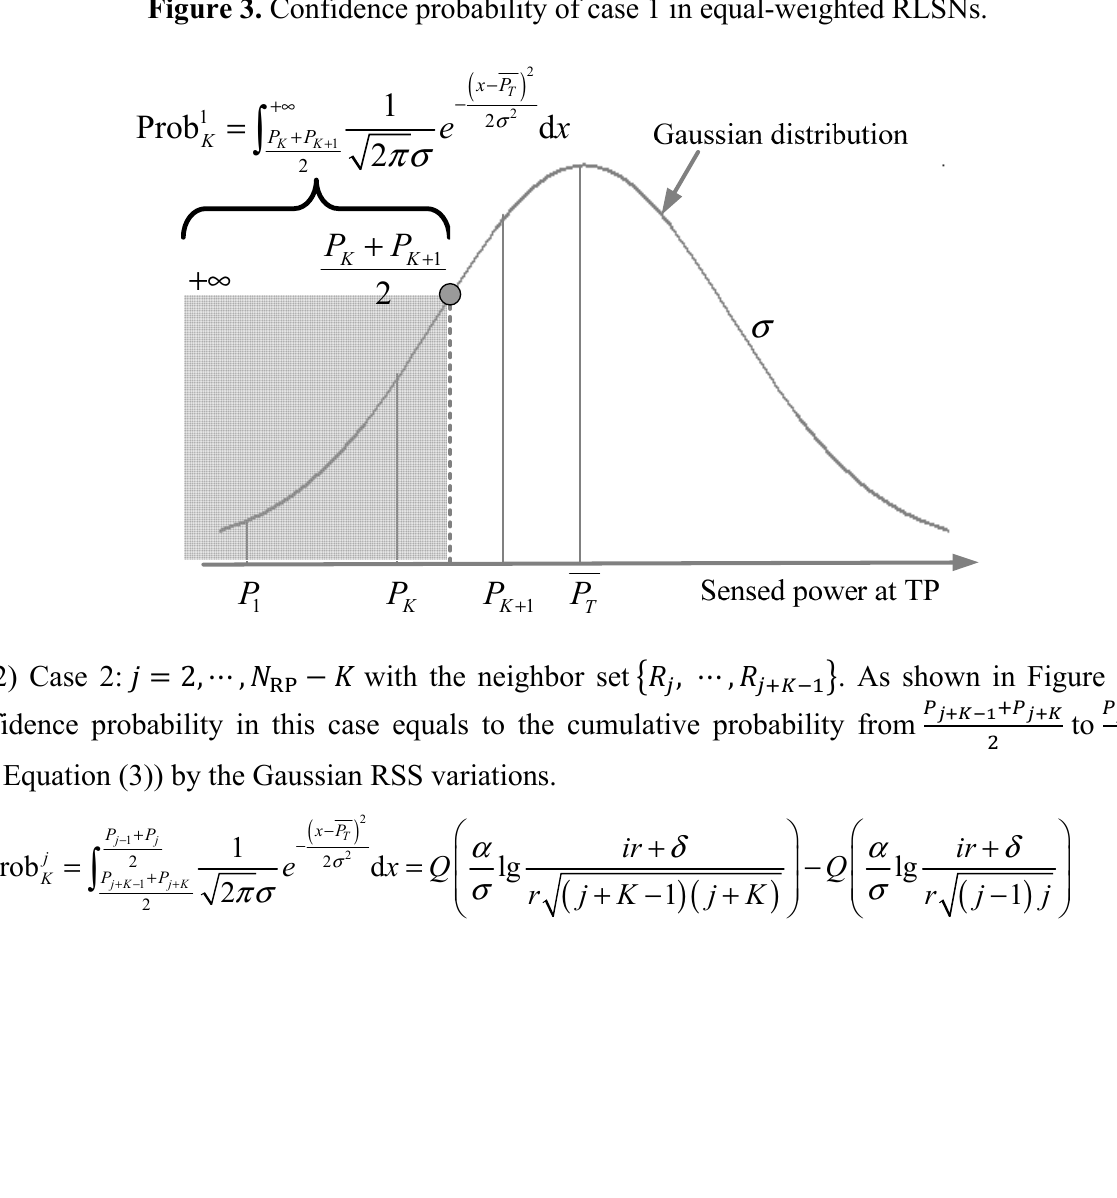
Figure 3. Confidence probability of case 1 in equal-weighted